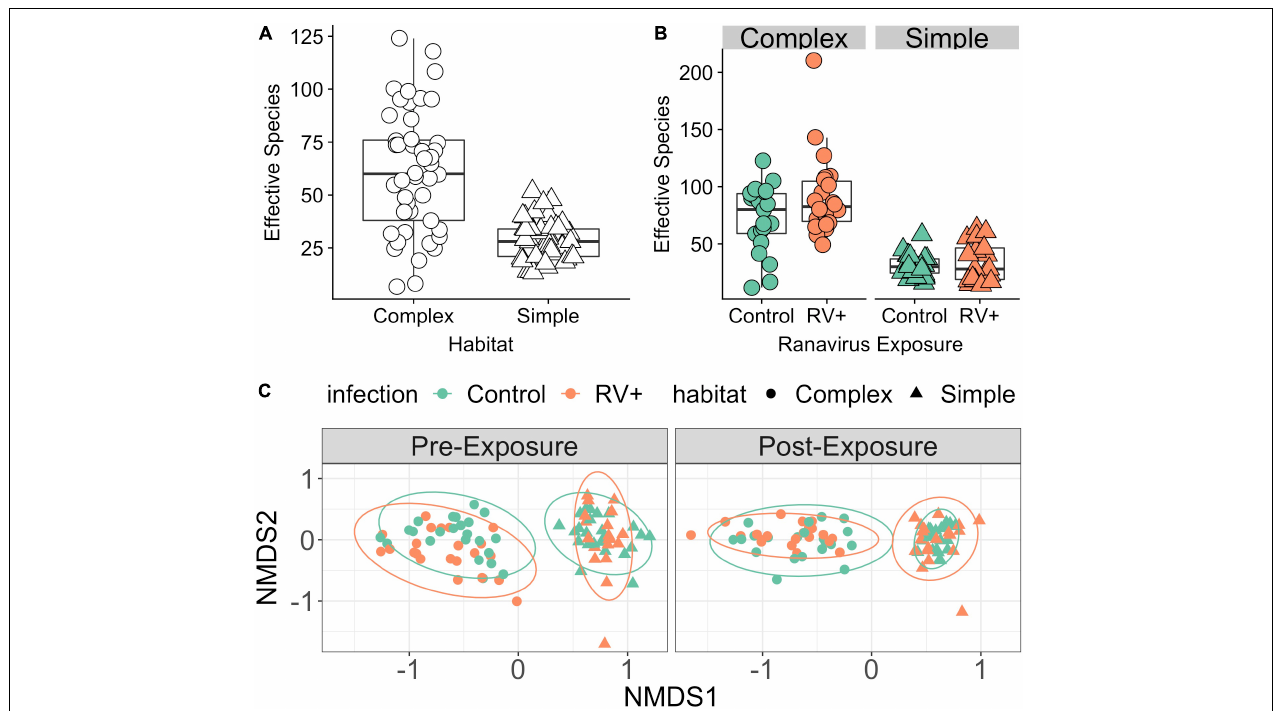
FIGURE 1 | Environment modifies host skin bacterial community structure. (A) Effect of environmental bacterial richness on host skin microbiome diversity (Experiment 1, Time Point 2 [pre-exposure]). Individuals in habitats with more species rich environmental bacterial reservoirs also had higher skin bacterial richness (Complex) compared to individuals in habitats with lower diversity bacterial reservoirs (Simple). (B) There was no effect of exposure to ranavirus on mean levels of bacterial richness in either habitat type (Experiment 1, Time Point 3 [post-exposure]). (C) Skin bacterial community structure (beta diversity) differed significantly based on habitat and time (pre- vs. post-exposure). We detected a significant three-way interaction between time, habitat and pathogen exposure, suggesting that ranavirus exposure causes shifts in community structure dependent on habitat complexity. Note that no individuals were exposed to ranavirus in the Pre- Exposure panel, but individual points are colored by pathogen treatment (ranavirus vs. control) in both panels to allow comparison of groups across time.